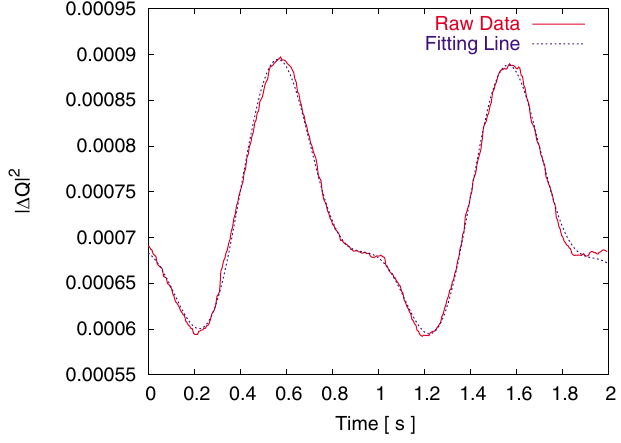
FIG. 4. (Color) Linear regression of j (cid:4) Q j 2 at injection.